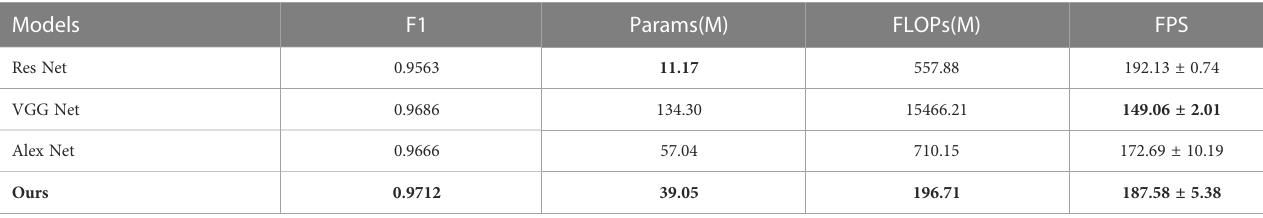
TABLE 5 Comparison of accuracy and ef fi ciency of the models.